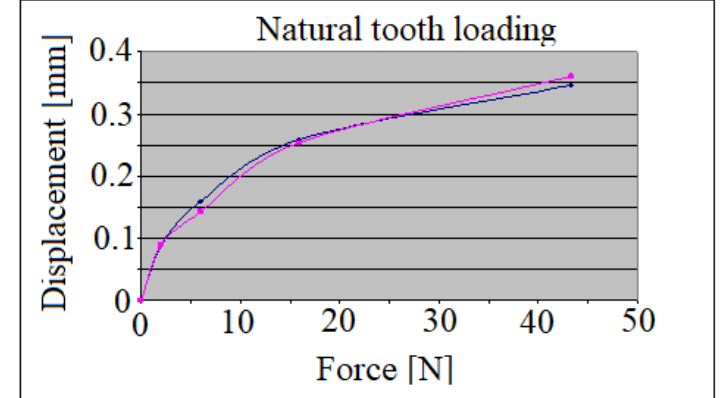
Figure 12. The relative displacements of the crowns during the natural tooth’s